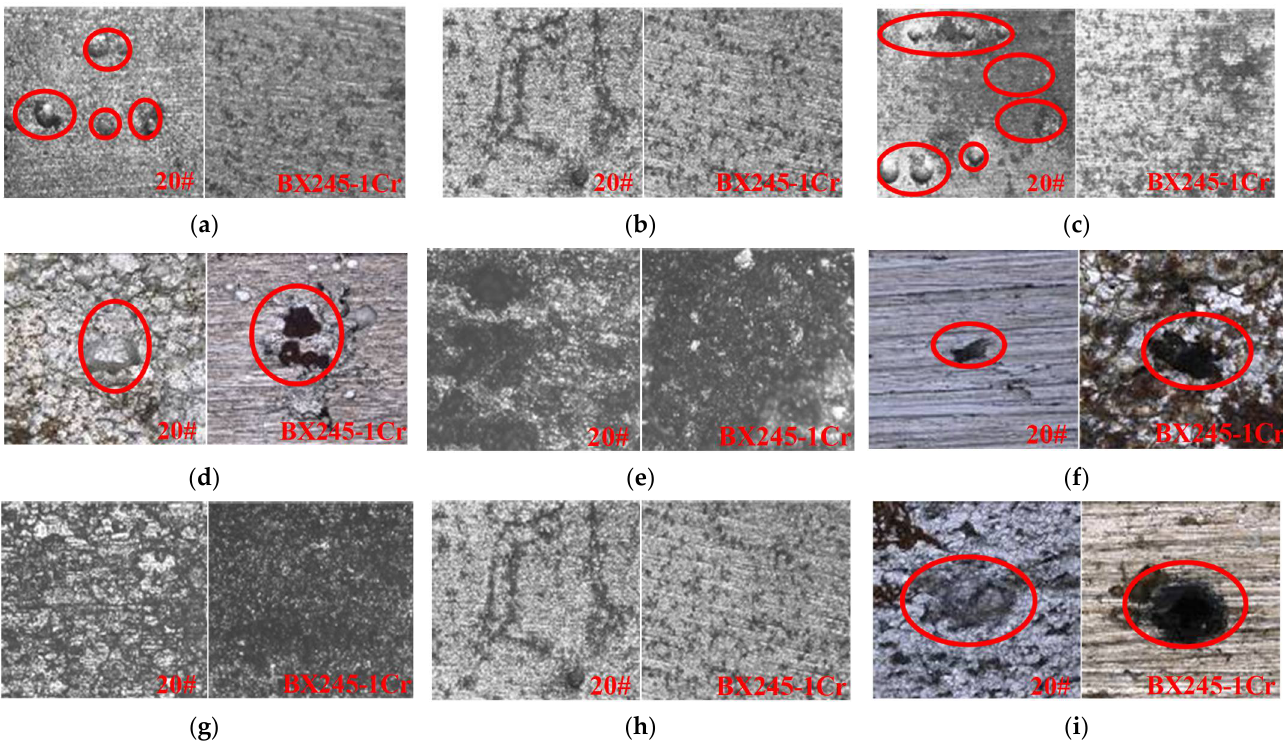
Figure 15. Microscopic corrosion morphology ( × 25 times) ( a ) Partial pressure of CO 2 = 0.01 MPa; ( b ) Partial pressure of CO 2 = 0.15 MPa; ( c ) Partial pressure of CO 2 = 0.45 MPa; ( d ) Partial pressure of H 2 S = 0.0003 MPa; ( e ) Partial pressure of H 2 S = 0.0008 MPa; ( f ) Partial pressure of H 2 S = 0.003 MPa; ( g ) Concentration of Cl − = 60,000 mg/L; ( h ) Concentration of Cl − = 110,000 mg/L; ( i ) Concentration of Cl − = 150,000 mg/L.